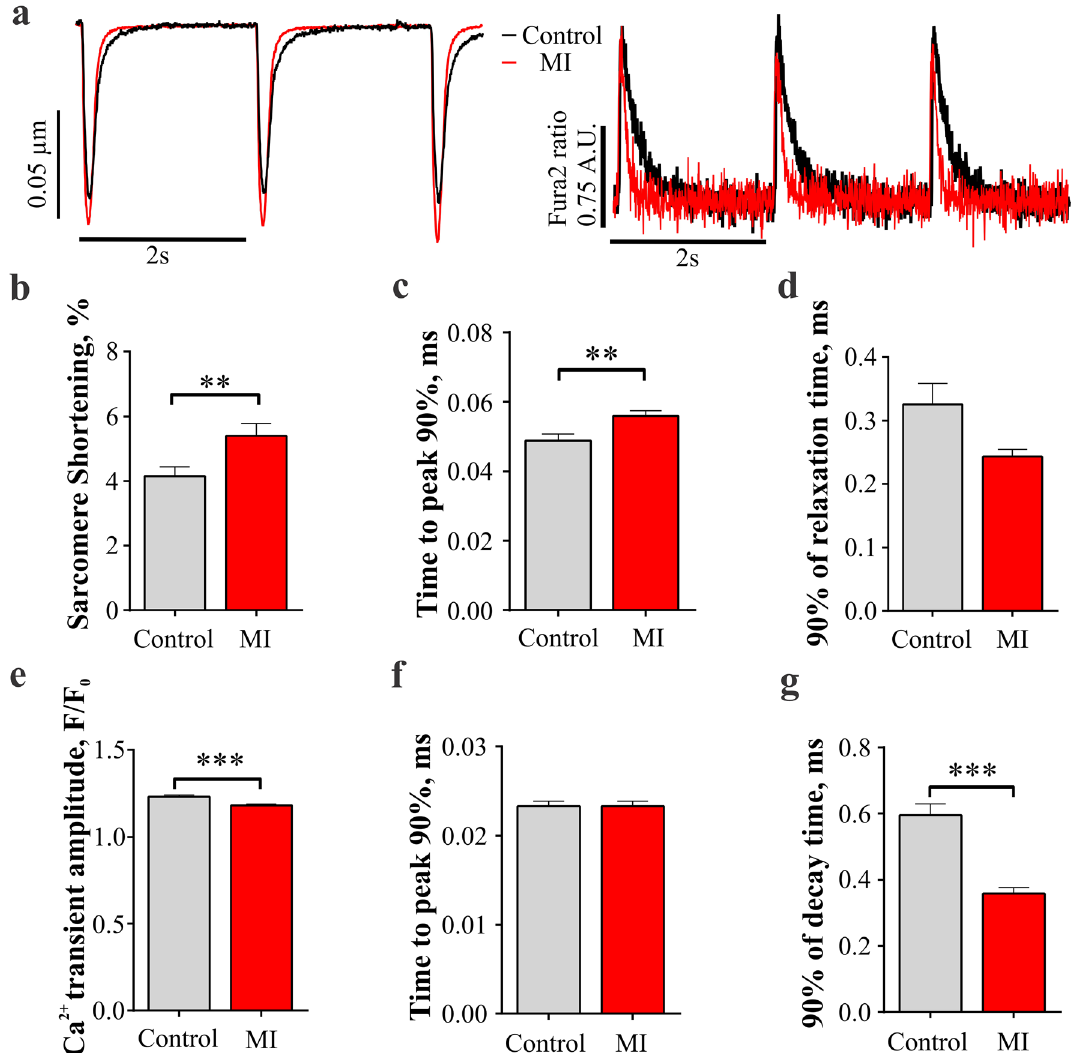
Figure 2. Sarcomere shortening and stimulated Ca 2+ transients in MI RVMs. (a) Representative rat sarcomere shortenings recordings and Ca 2+ transients traces in control and MI RVMs. (a) Average sarcomere shortening amplitude , (b) time to 90% peak (TTP90) and (c) time from peak to 10% of baseline (TTB90) measured at 0.5 Hz for both control and MI RVMs. Control n = 104 cells from 4 rats, MI n = 74 from 3 rats. **P < 0.01, by Mann–Whitney test. (e) Amplitude of calcium transient (F/F 0 ), (f) time to 90% peak from 10% baseline (TTP90) and (g) time from peak to 10% of baseline (90% decay time) were measured at 0.5 Hz in control and MI RVMs. Control n = 158 cells from 4 rats, MI n = 95 from 3 rats. ***P < 0.001, by Mann–Whitney